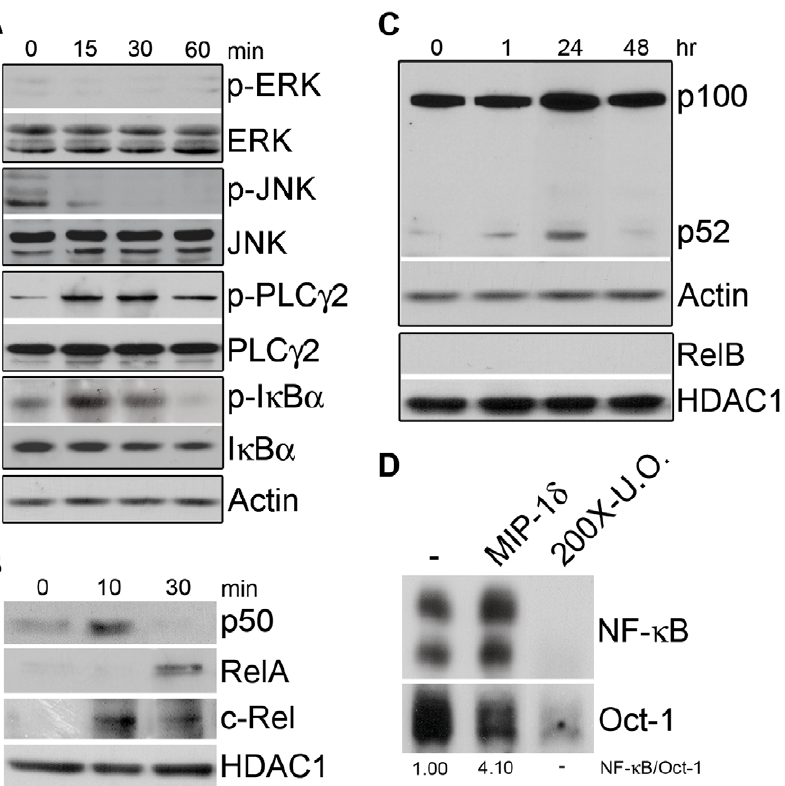
Figure 2. MIP-1 d activates PLC c 2 and NF- k B signaling pathways in OCL progenitors. BMM were treated with or without MIP-1 d (0.1 pg/ml) and the effect on the ERK, JNK, PLC c 2, and NF- k B signaling pathways was examined by Western analysis. ( A ) The effect of MIP-1 d on the levels of total and phospho (p)-ERK, JNK, PLC c 2, and I k B a was examined using equal amounts of protein from total cell lysates. ( B ) Nuclear translocation of p50, RelA, c-Rel, and ( C ) RelB following MIP-1 d treatment was determined using equal amounts of protein from nuclear cell lysates. ( C ) Processing of p100 to p52 following MIP-1 d treatment was determined using equal amounts of protein from total cell lysates. ( D ) Activation of NF- k B was determined 30 minutes following treatment with MIP-1 d by non-radioactive EMSA analysis of nuclear cell lysates using NF- k B oligonucleotides. Oct-1 served as a loading control and 200-fold excess unlabeled oligonucleotide (200X-U.O.) served as a competitive control. Densitometry values are provided below respective lanes for ease of interpretation. Data are representative of at least two independent experiments.